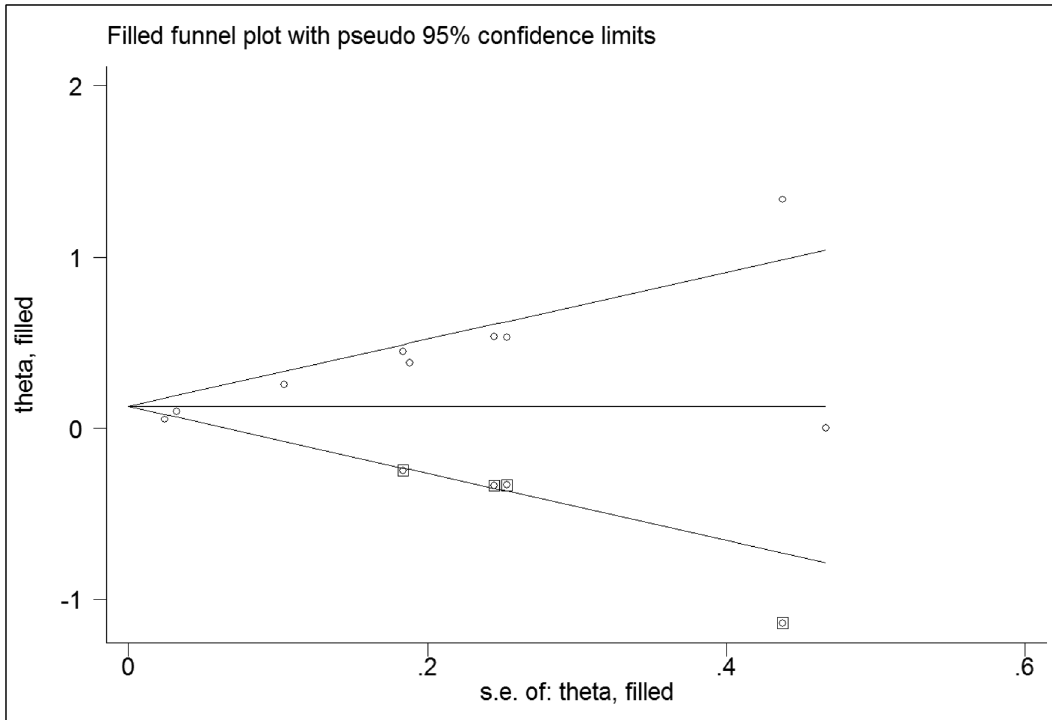
Figure 5 - Funnel plots adjusted with the trim and fill method for OS. Circles: included studies. Diamonds: presumed missing